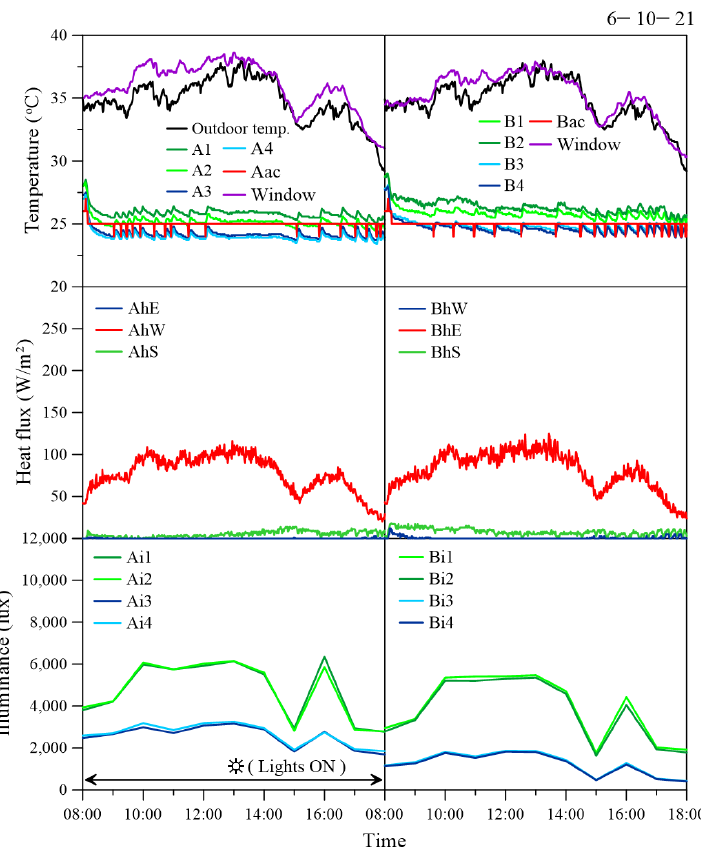
Figure 6. Indoor and outdoor environment data history diagram on June 10th.